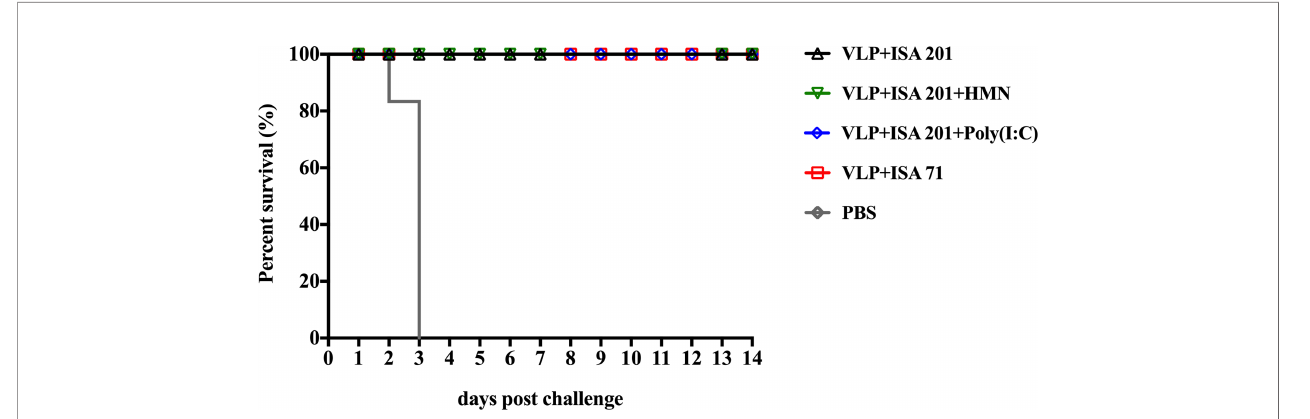
FIGURE 8 | Survival rates of the speci fi c pathogen-free (SPF) chickens after H7N9-E157 virus challenge. At 3 weeks postvaccination, groups of SPF chickens ( n = 10) were intranasally challenged with a high lethal dose (10 6.0 EID 50 ) of A/Chicken/Guangdong/E157/2017 H7N9 AIVs. Survival rates of chickens were measured daily for 2 weeks after challenge.